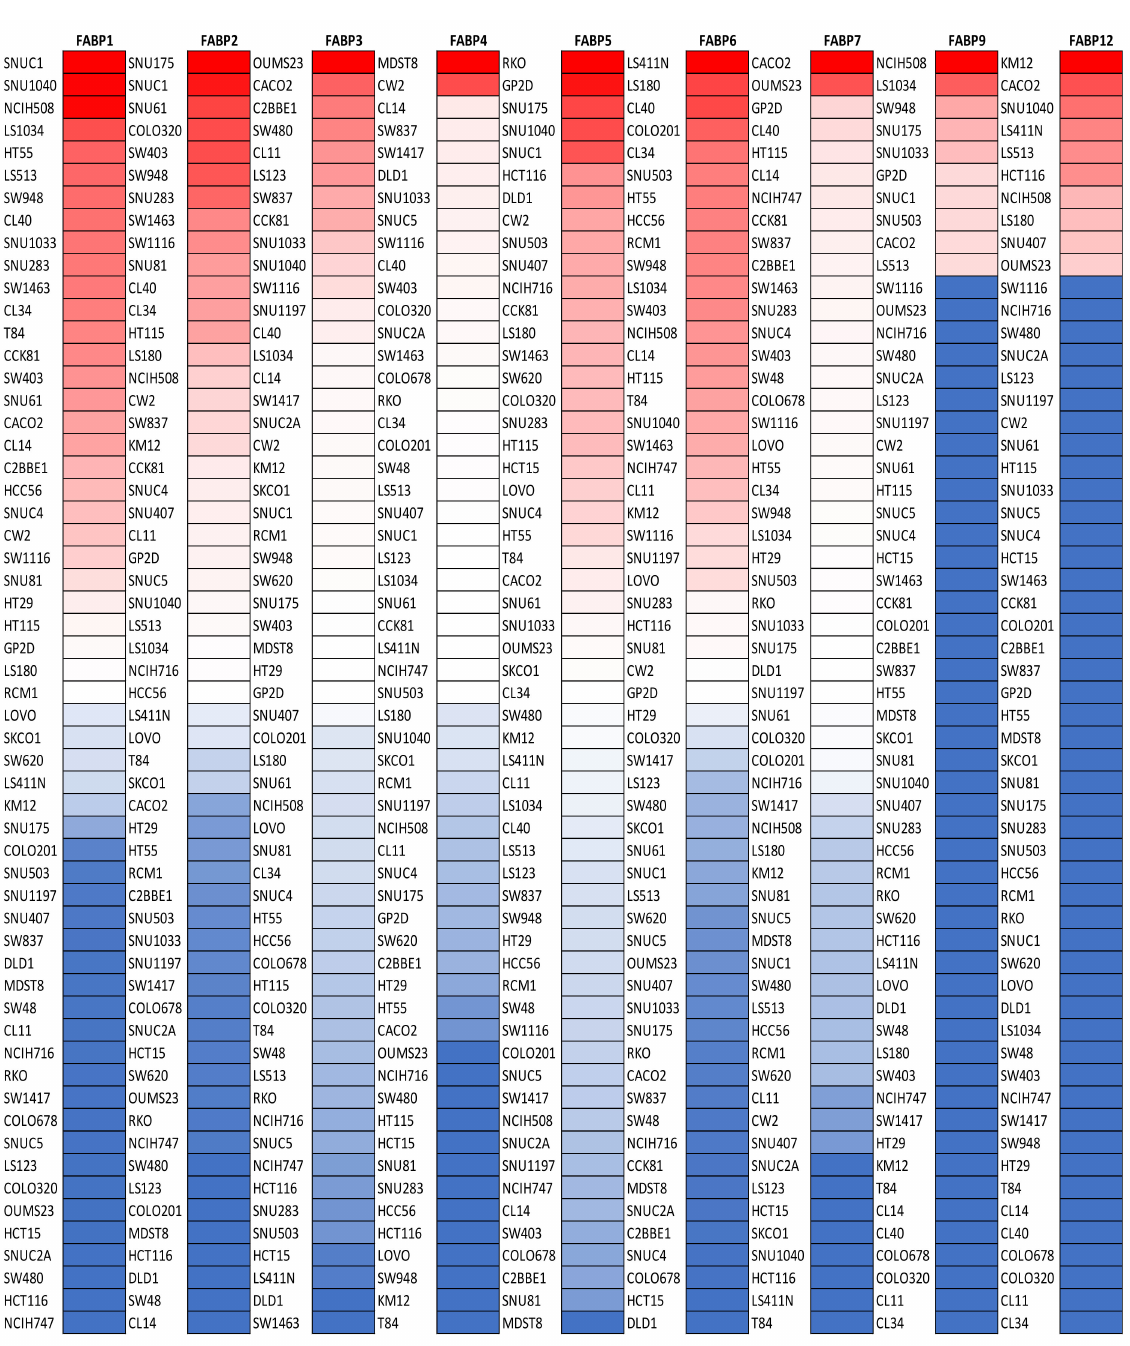
Figure 2. Heatmap of fatty acid-binding protein ( FABP ) gene mRNA expressions in colorectal cancer cell lines (CCLEs), with red signifying overexpression and blue suggesting